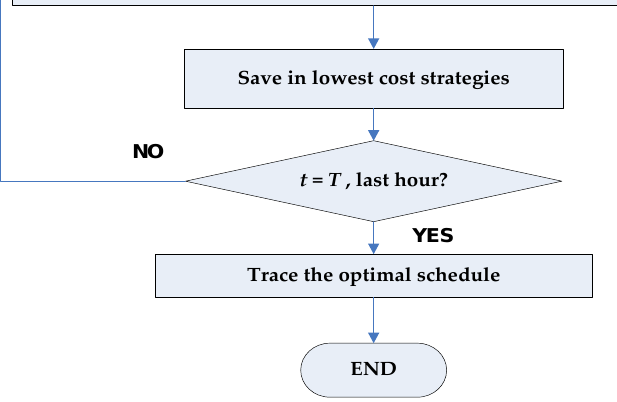
Figure 2. The flowchart of forward dynamic programming algorithm.